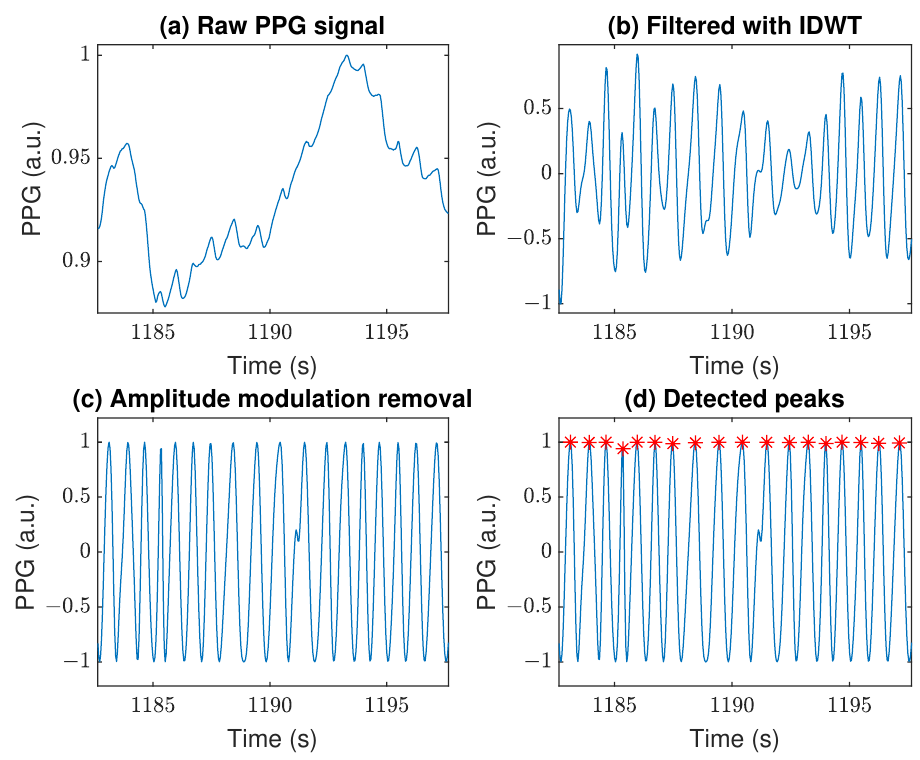
Figure 4. Example of PPG signal filtering: ( a ) Raw PPG signal obtained from the Samsung device, ( b ) Signal filtered with the IDWT, ( c ) Results of amplitude modulation removal, ( d ) Example of detected peaks (red asterisks) with the AMPD algorithm. The Arm experiment, person P6.